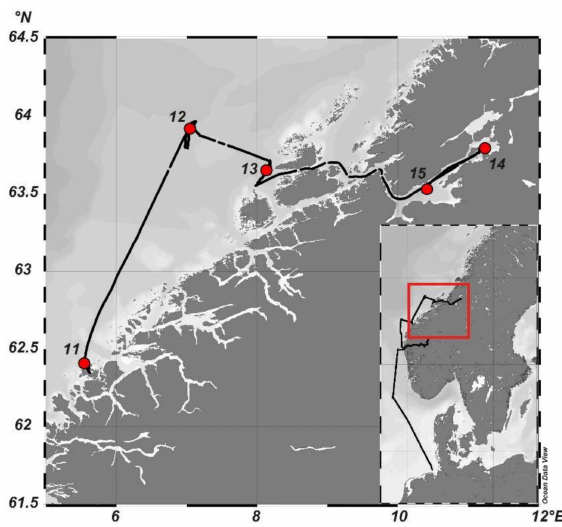
Figure 6. Overview of the study area (insert). Map shows Trondheimsfjord and its adjacent coastal sea with cruise track (solid black line) and stations (red dots) of R/V Heincke expedition